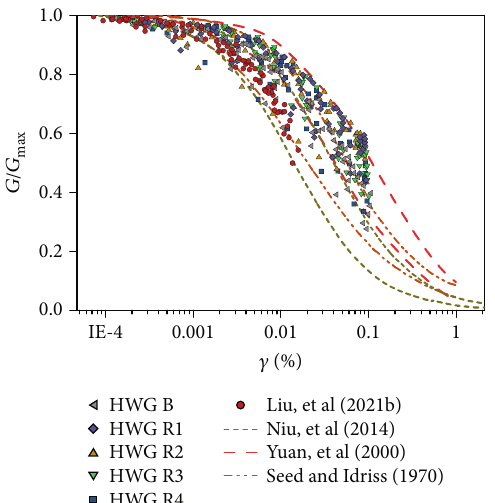
Figure 14: Variation in normalized dynamic shear modulus with shear strain. Data source: Niu et al. [3], Seed and Idriss [10], Yuan et al. [30], and Liu, X. et al.